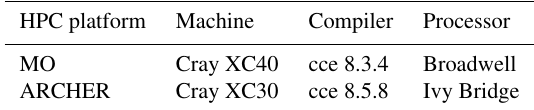
Table 1. Hardware and software specifications of the ARCHER and MO HPC platforms as used to run the HadGEM3-GC3.1 model. HPC